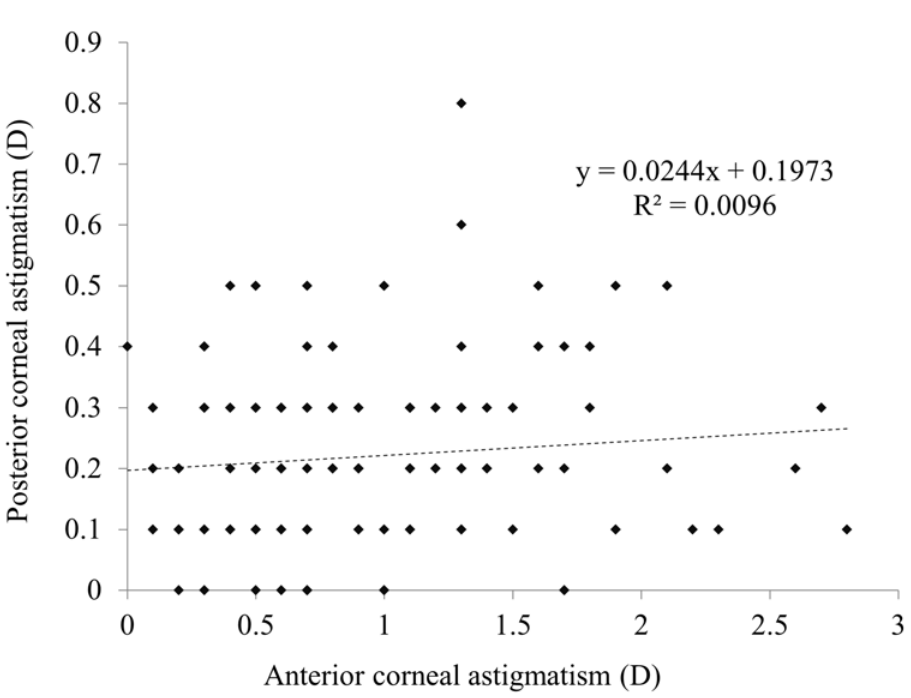
Fig 5. A graph showing no significant correlation between the magnitudes of anterior and posterior corneal astigmatism (Pearson correlation coefficient r = 0.1010, P = 0.2918) in eyes against-the-rule (ATR) anterior corneal astigmatism.